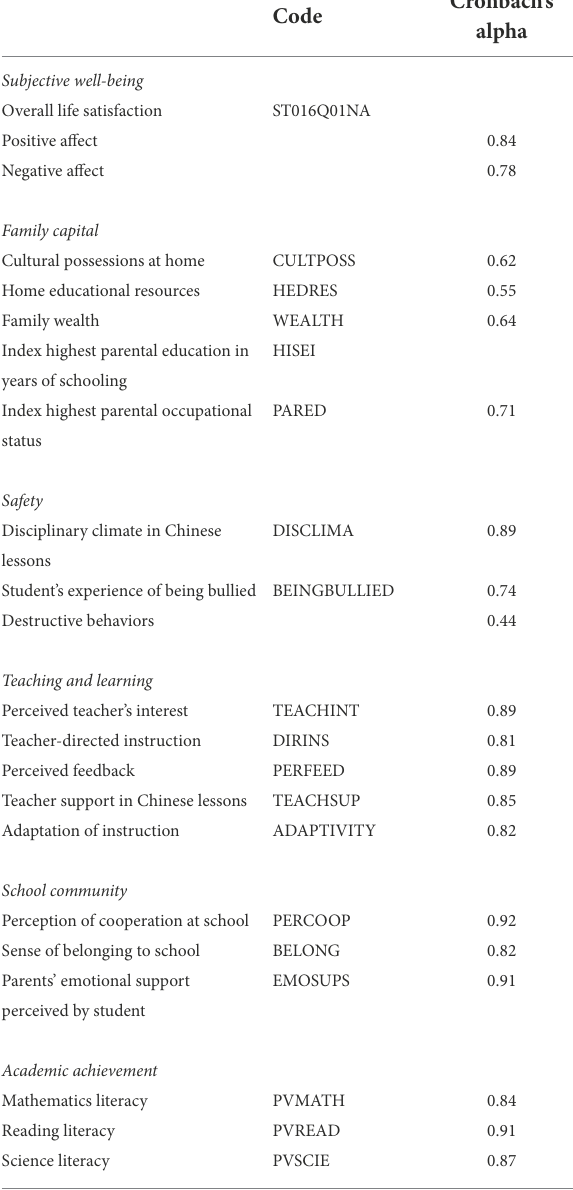
TABLE 4 List of variables.